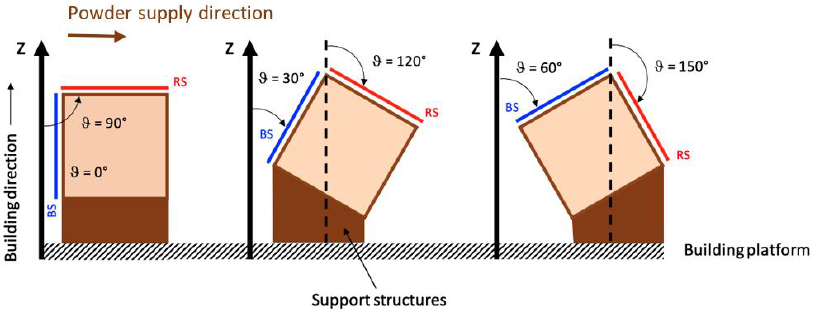
Figure 2. Building angle ( θ ) definition and analyzed surfaces: blue surface ( BS ) and red surface ( RS ).